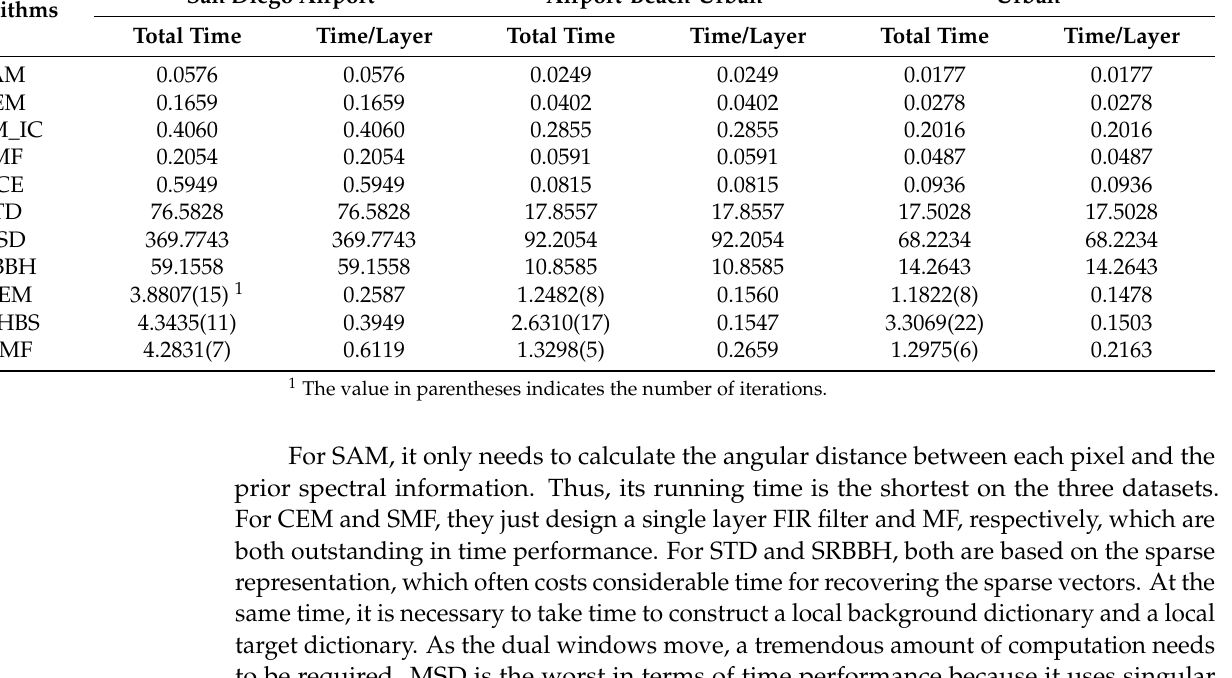
Table 4. Time performances of different detectors on the three datasets (keep four decimal places in the units of seconds).